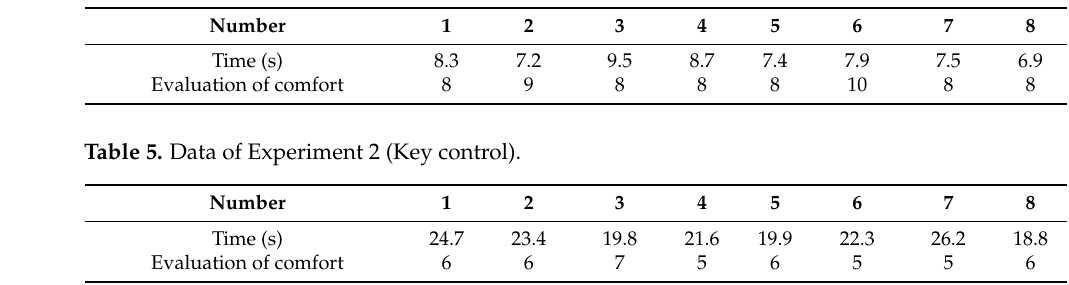
Table 4. Data of Experiment 1 (Combination of three channels).